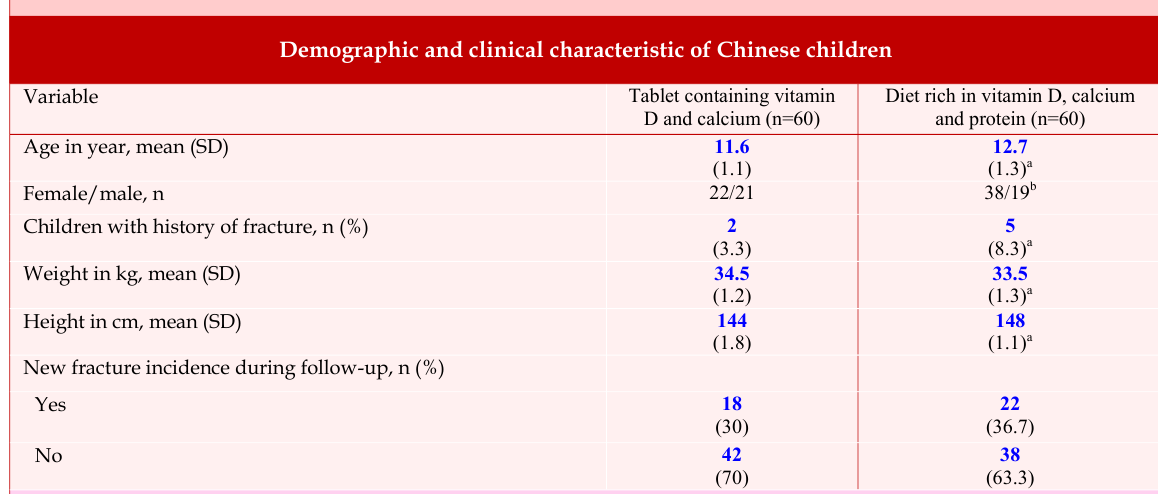
Demographic and clinical characteristic of Chinese